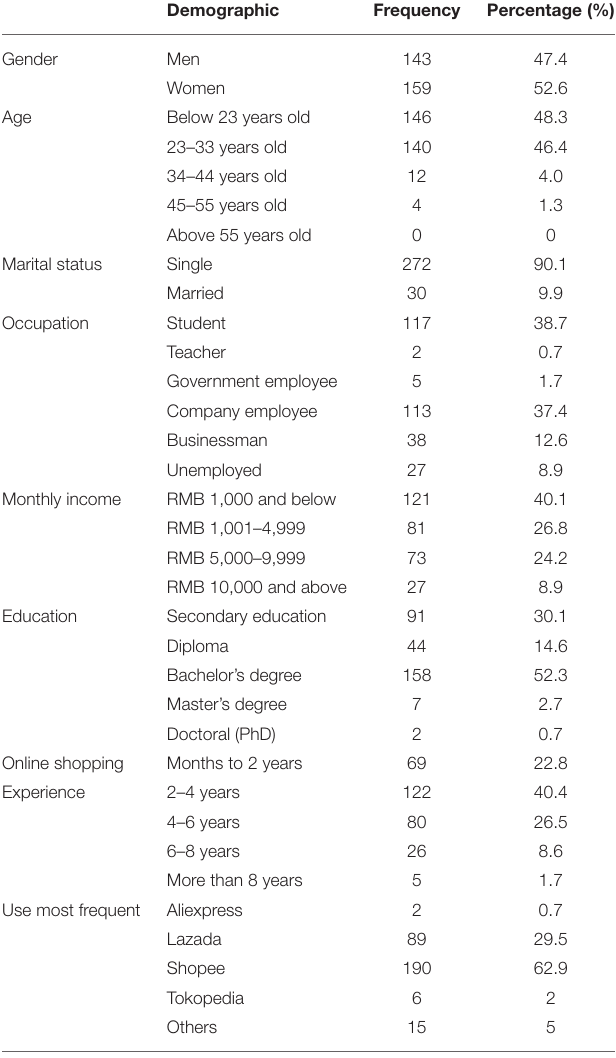
TABLE 1 | Respondents’ demographic profile.